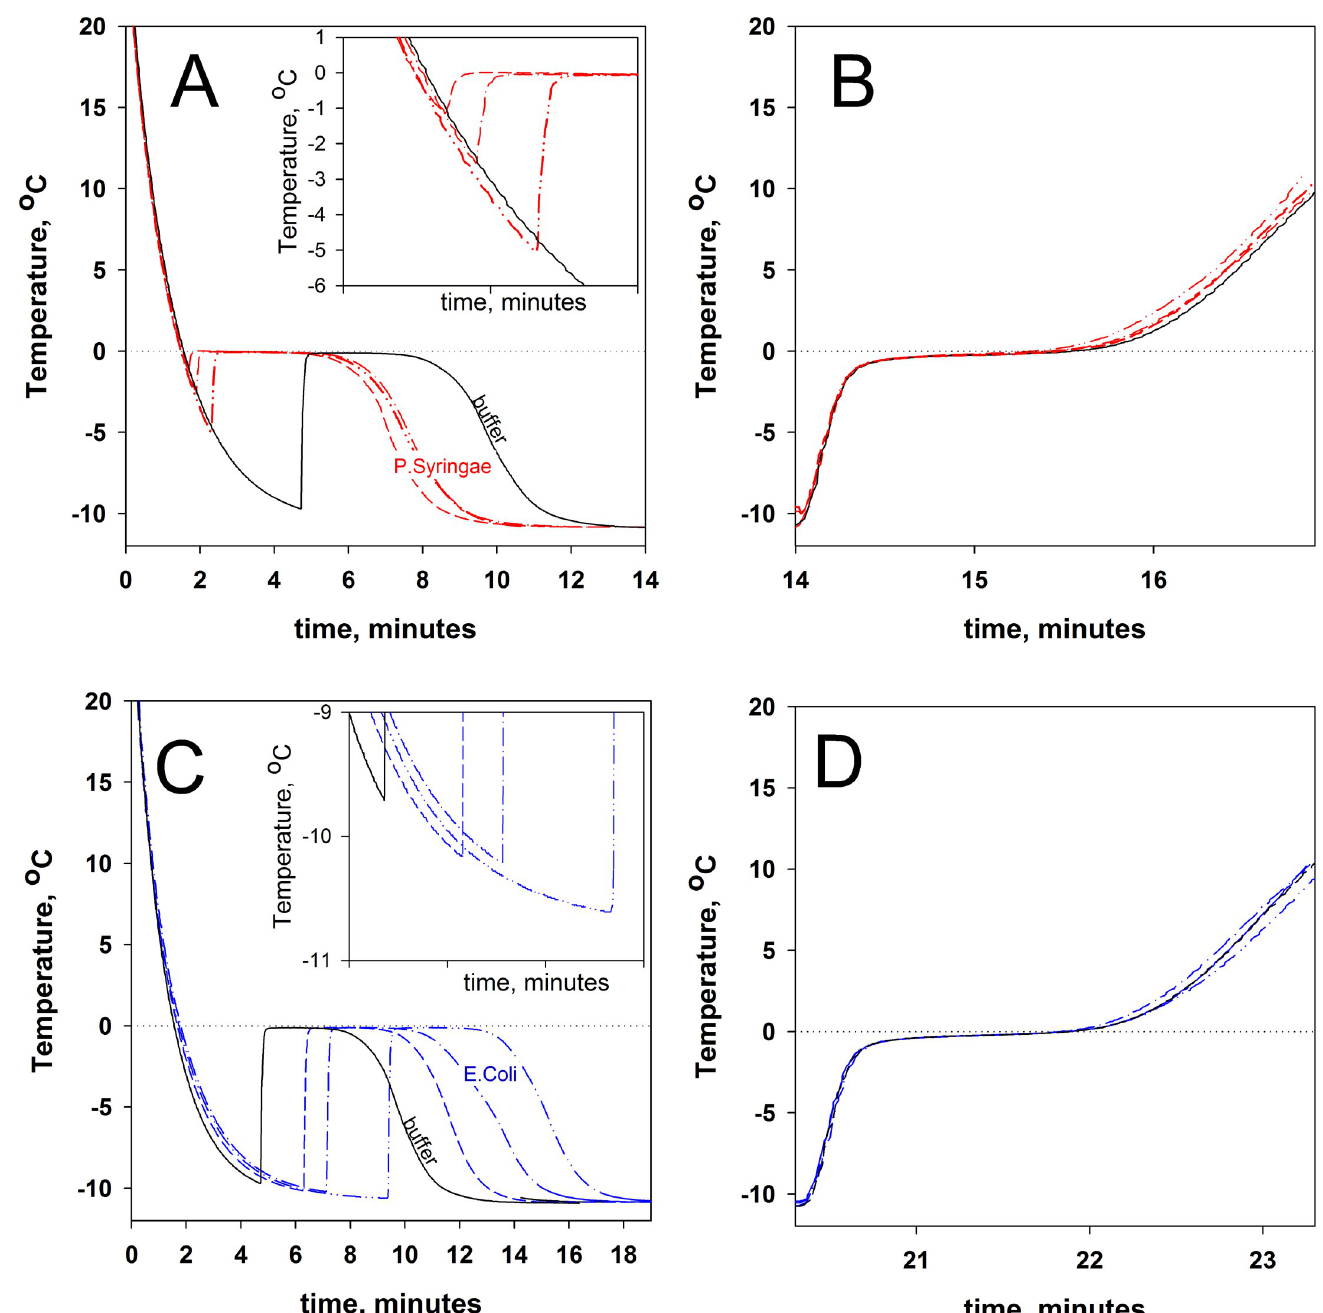
Fig 2. Time dependence of sample temperatures during cooling (A and C) and heating (B and D). The curve for the 20mM Tris-HCl buffer, pH 7.5, is shown on all graphs as a black solid line. On A and B, the curves for P . syringae solutions with a cell concentration of 0.19 (--), 0.03(- � -), and 0.003(- �� -) optical units are shown in red. On C and D, the curves for E coli solutions with a cell concentration of 0.02(--), 0.2(- � -), and 0.001(- �� -) optical units are in blue. The inserts on A and C show the curve stretch from which the freezing point of water T f has been